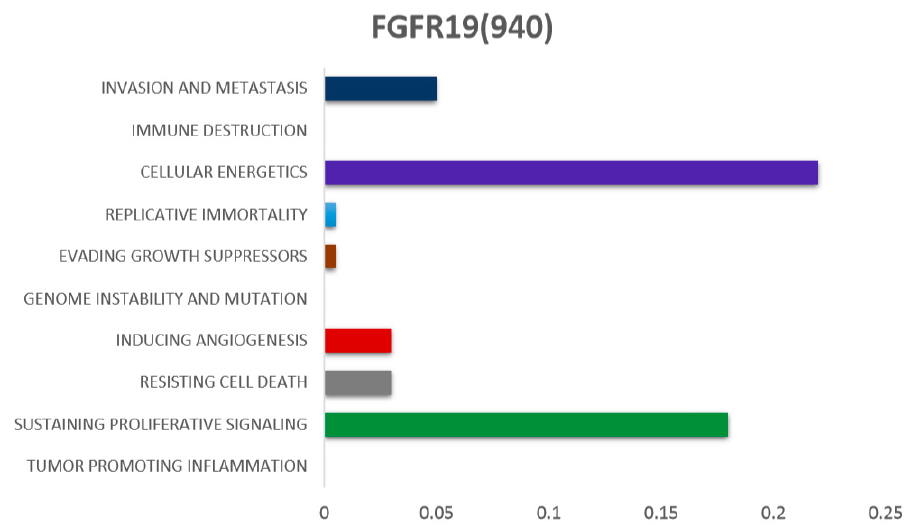
Figure 3. The association of FGF19 with different hallmarks of cancer, as reported in the literature. (Scales of bars from left to right represent the lowest to highest number of associations reported)